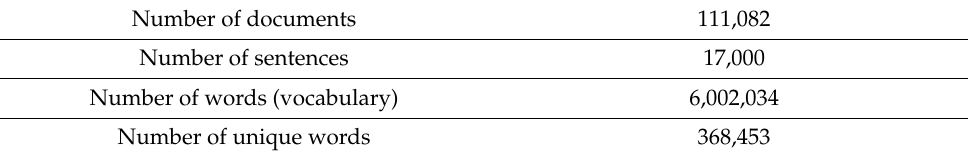
Figure 5. Sentence classification using the CNN.